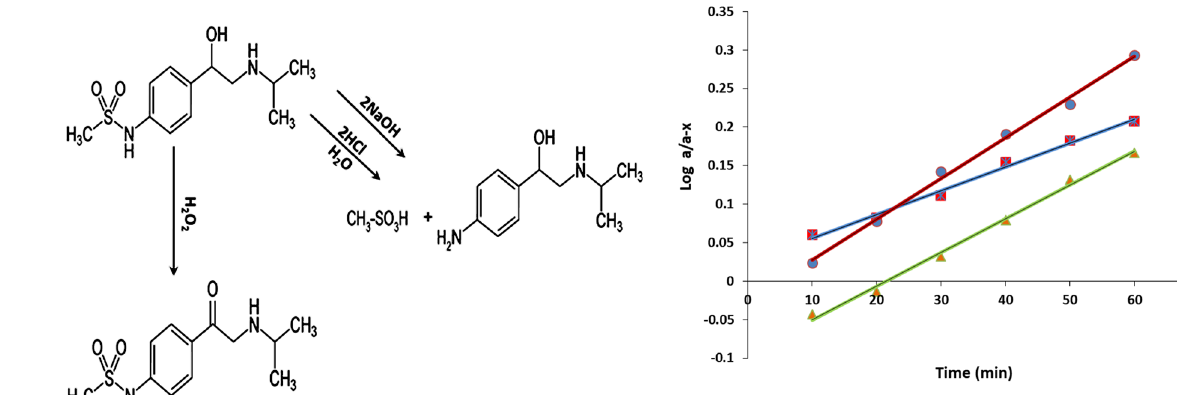
Scheme 1: The proposed pathway of alkaline, acidic and oxidative degradation of SOT.